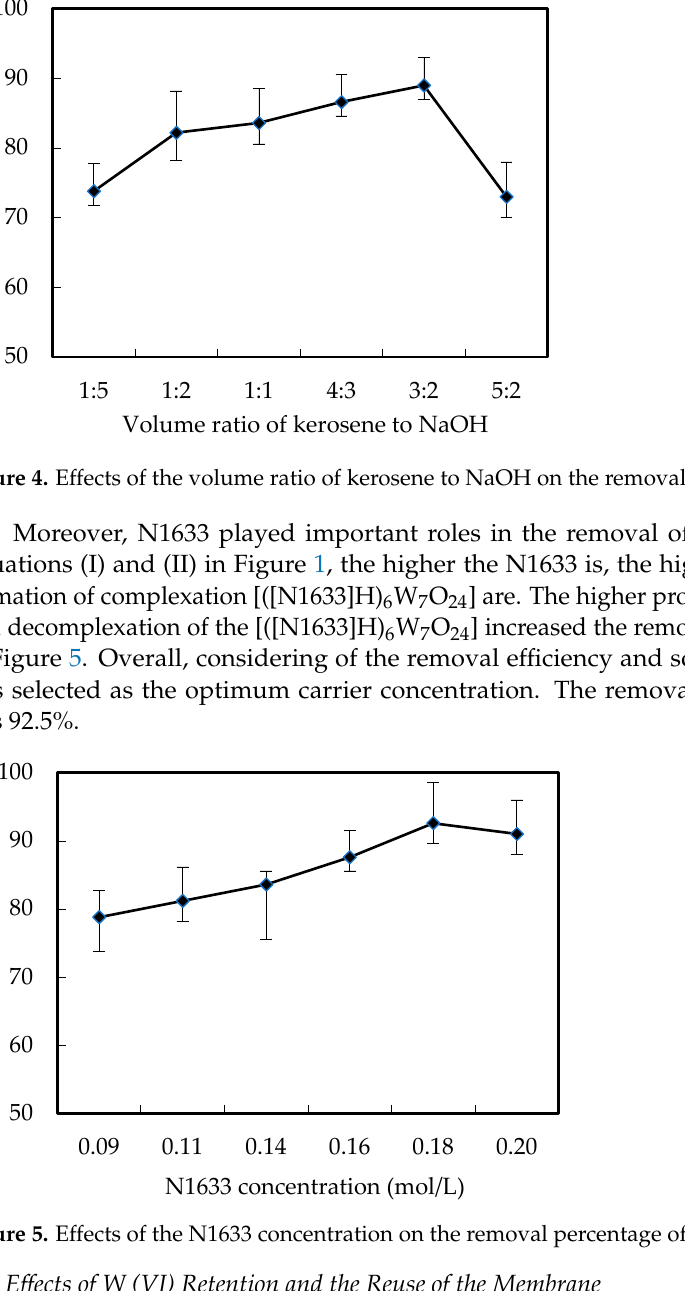
Figure 5. Effects of the N1633 concentration on the removal percentage of W (VI).